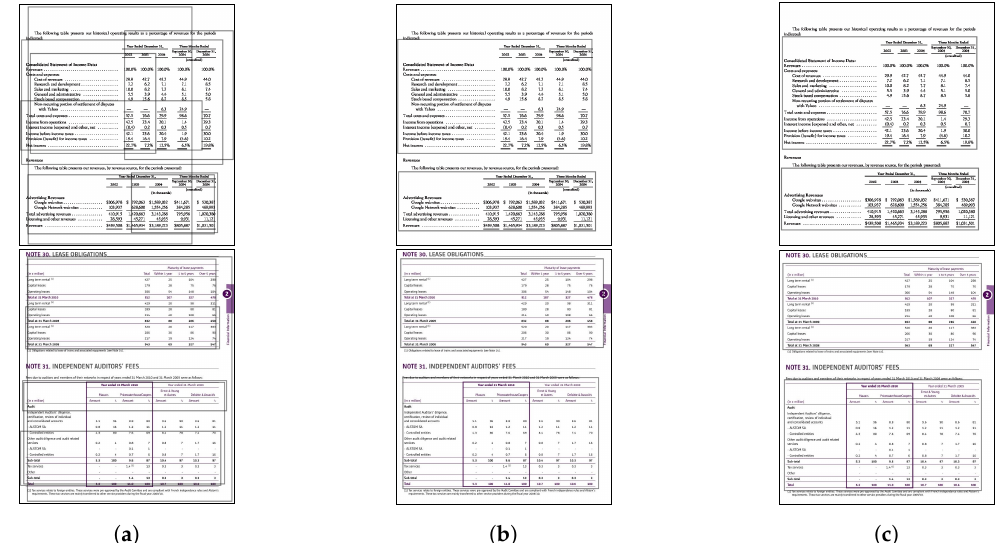
Figure 8. Detection results of IIIT-AR-13K obtained from the baseline, Faster-RCNN+ResNet- 50+DyHead, and Faster-RCNN+ConvNeXt+DyHead. The color black represents tables in the sub- figures. ( a ) The samples obtained from the baseline model. ( b ) The corresponding samples obtained with attention mechanism incorporated into the pipeline followed in baseline model. ( c ) The detec- tions on samples by the Faster-RCNN+ConvNeXt+DyHead variant. Attention mechanism-based results have no signs of erroneous detections of Tables as compared to the baseline. Table 7. The model performance results for ConvNeXt+DyHead backbone with Faster-RCNN (bbox) on